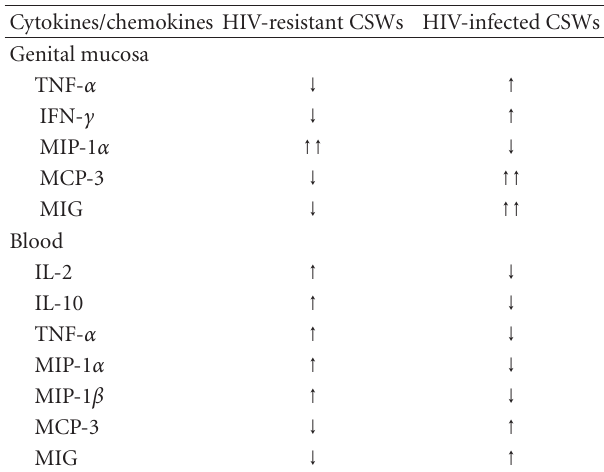
Table 2: Cytokines and chemokines significantly associated with resistance to HIV-1 infection in the Beninese HIV-1-uninfected and infected CSW